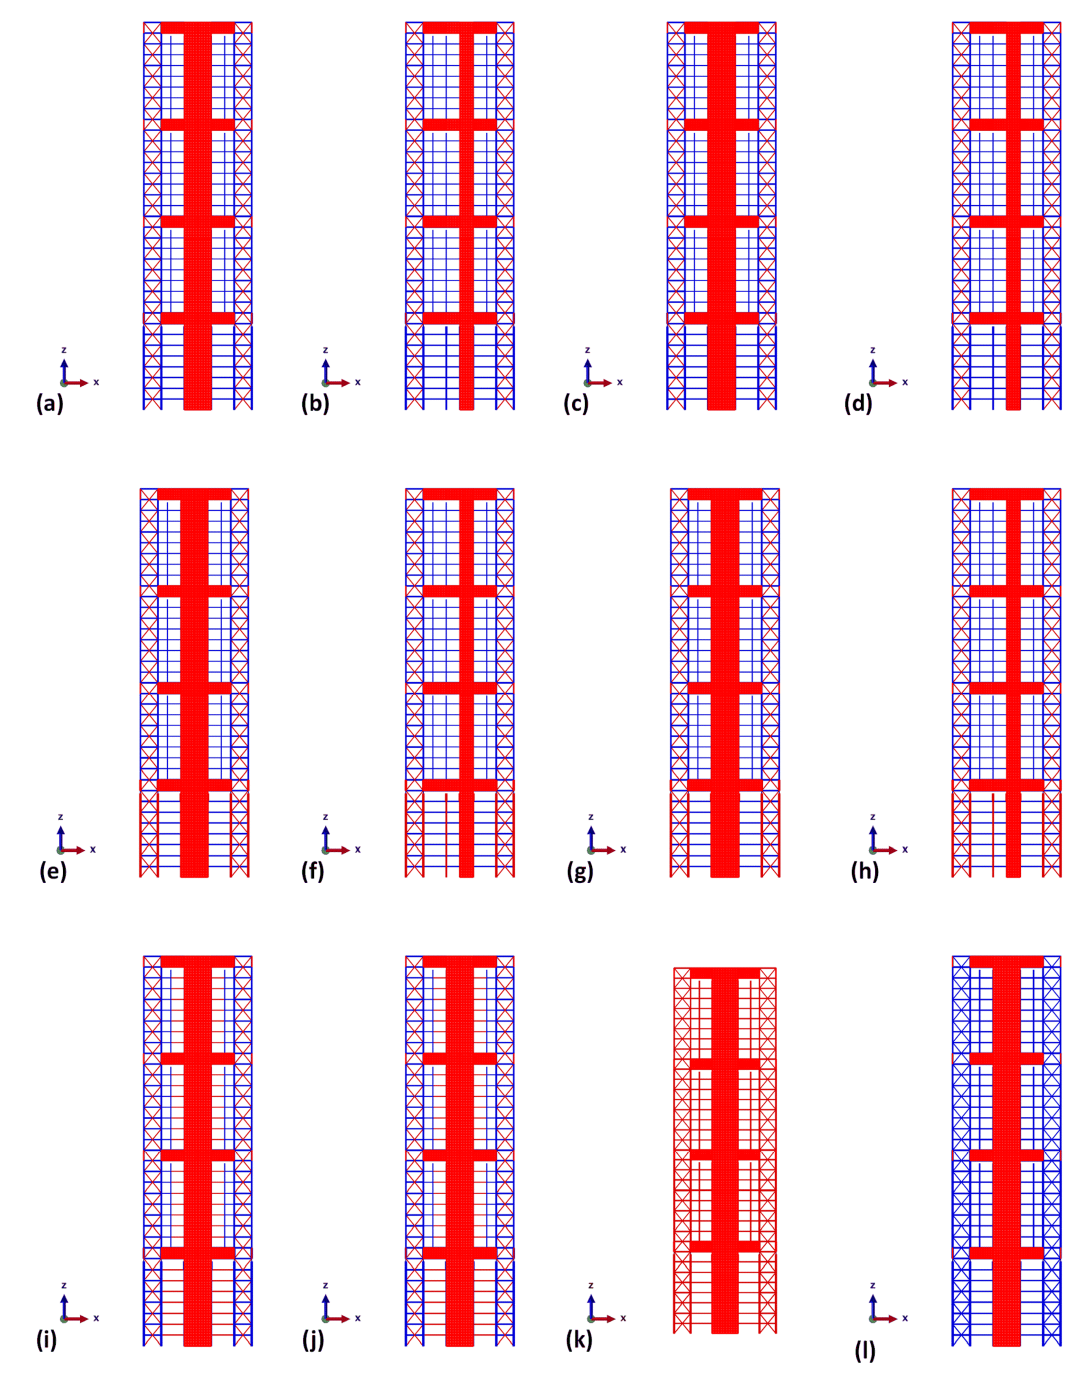
Figure C2. Structural configuration: ( a ) Conf. 13, ( b ) Conf. 14, ( c ) Conf. 15, ( d ) Conf. 16, ( e ) Conf. 17, ( f ) Conf. 18, ( g ) Conf. 19, ( h ) Conf. 20, ( i ) Conf. 21, ( j ) Conf. 22, ( k ) Conf. 23, and ( l ) Conf. 24 .